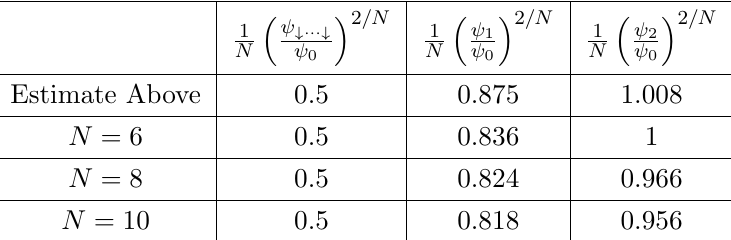
Table 2 . Comparison of large N , k = 1 estimates above with an explicit Bethe Ansatz sum of the corresponding subsets of images F at N = 6, N = 8 and N = 10. In the last three rows, the three columns sum over (1) F = # (cid:1) (cid:1) (cid:1) # , (2) over all combinations of arrows and (3) over all combinations of arrows with arbitrary insertions of 20 and 02. Note that the (cid:12)rst column agrees for all N as #(cid:1)(cid:1)(cid:1)# is calculated exactly. When N (cid:20) 6 all possible images F either consist entirely of arrows or have a single 20 or 02 insertion, so the sum over all such images yields the full S N